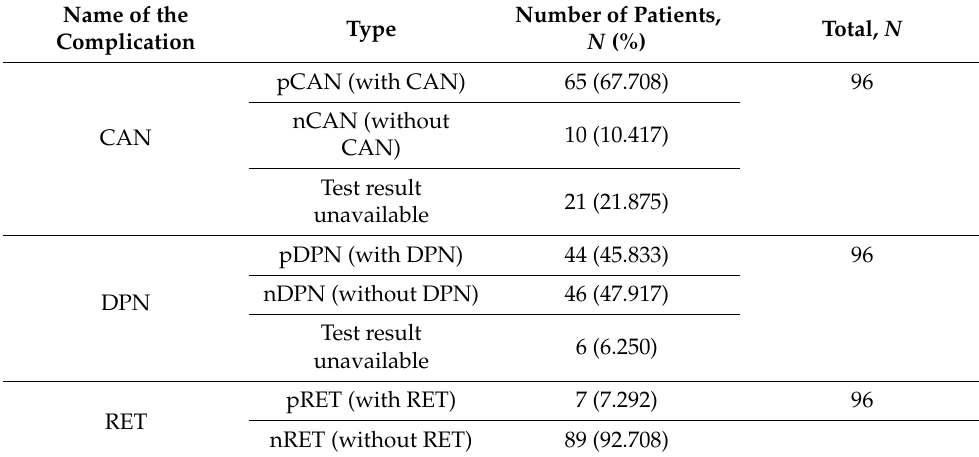
Table 1. Types of complications of patients included in this